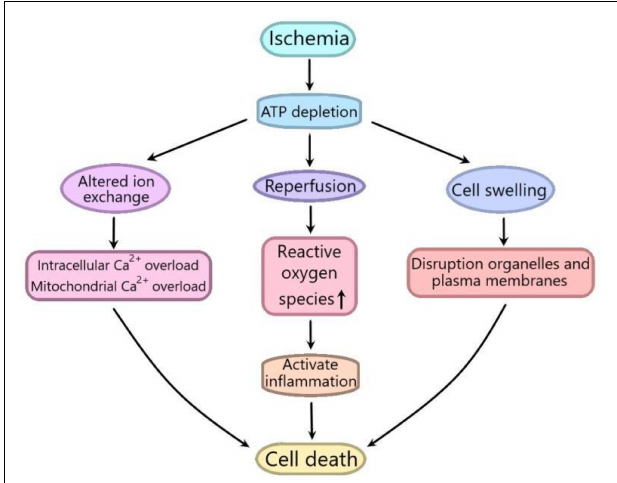
FIGURE 1 | Schematic diagram of the mechanism of ischemia/reperfusion (I/R) injury. Ischemia increases intracellular and mitochondrial calcium levels by interfering with ATPase dependent ion transport. At the same time, the mechanism of cell volume regulation is also destroyed by the lack of ATP, which can cause the dissolution of organelles and plasma membranes. Although reperfusion can save hypoxic tissue, it can promote the production of reactive oxygen species, isolate pro-inflammatory immune cells in ischemic tissue, and aggravate tissue